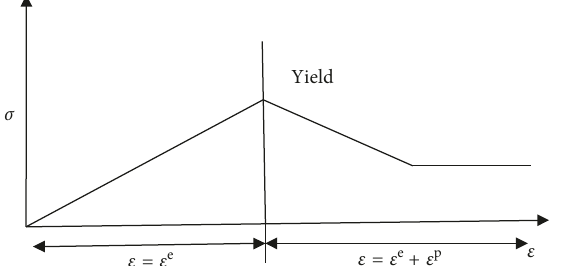
Figure 7: Numerical model.